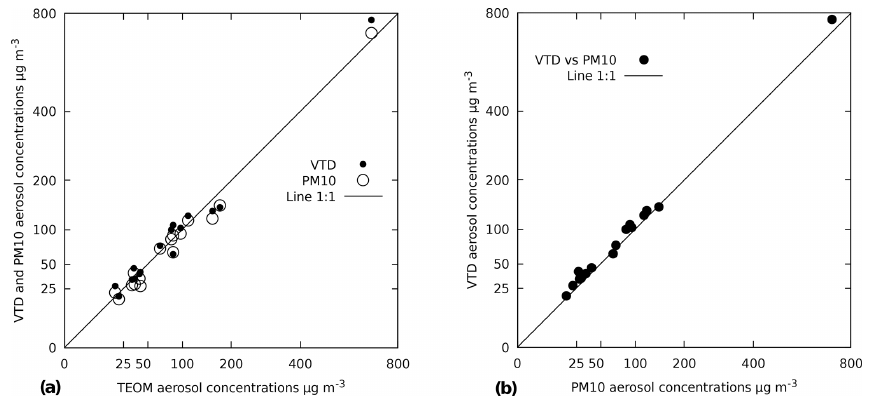
Figure 6. Comparisons of sample masses using a square-root scale. The lines y = x are also shown. (a) Plot of chemically deduced mass of VTD and PM10 sampling heads vs. TEOM measurement. (b) Plot of chemically deduced mass of VTD vs. PM10 sampling